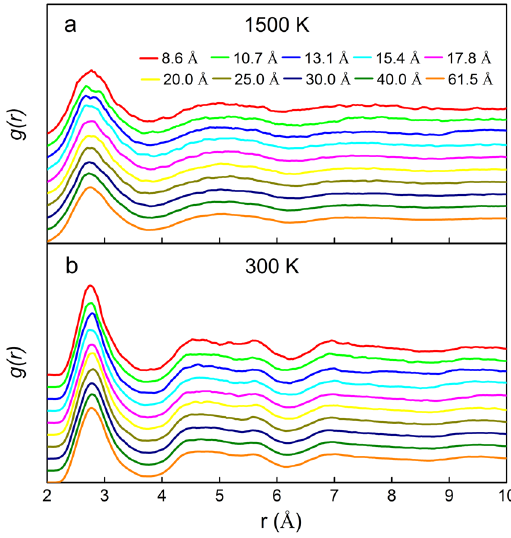
Figure 7. Pair distribution functions g(r) for Cu 64 Zr 36 SSAFs with various thicknesses at ( a ) 1500 K and ( b ) 300 K.